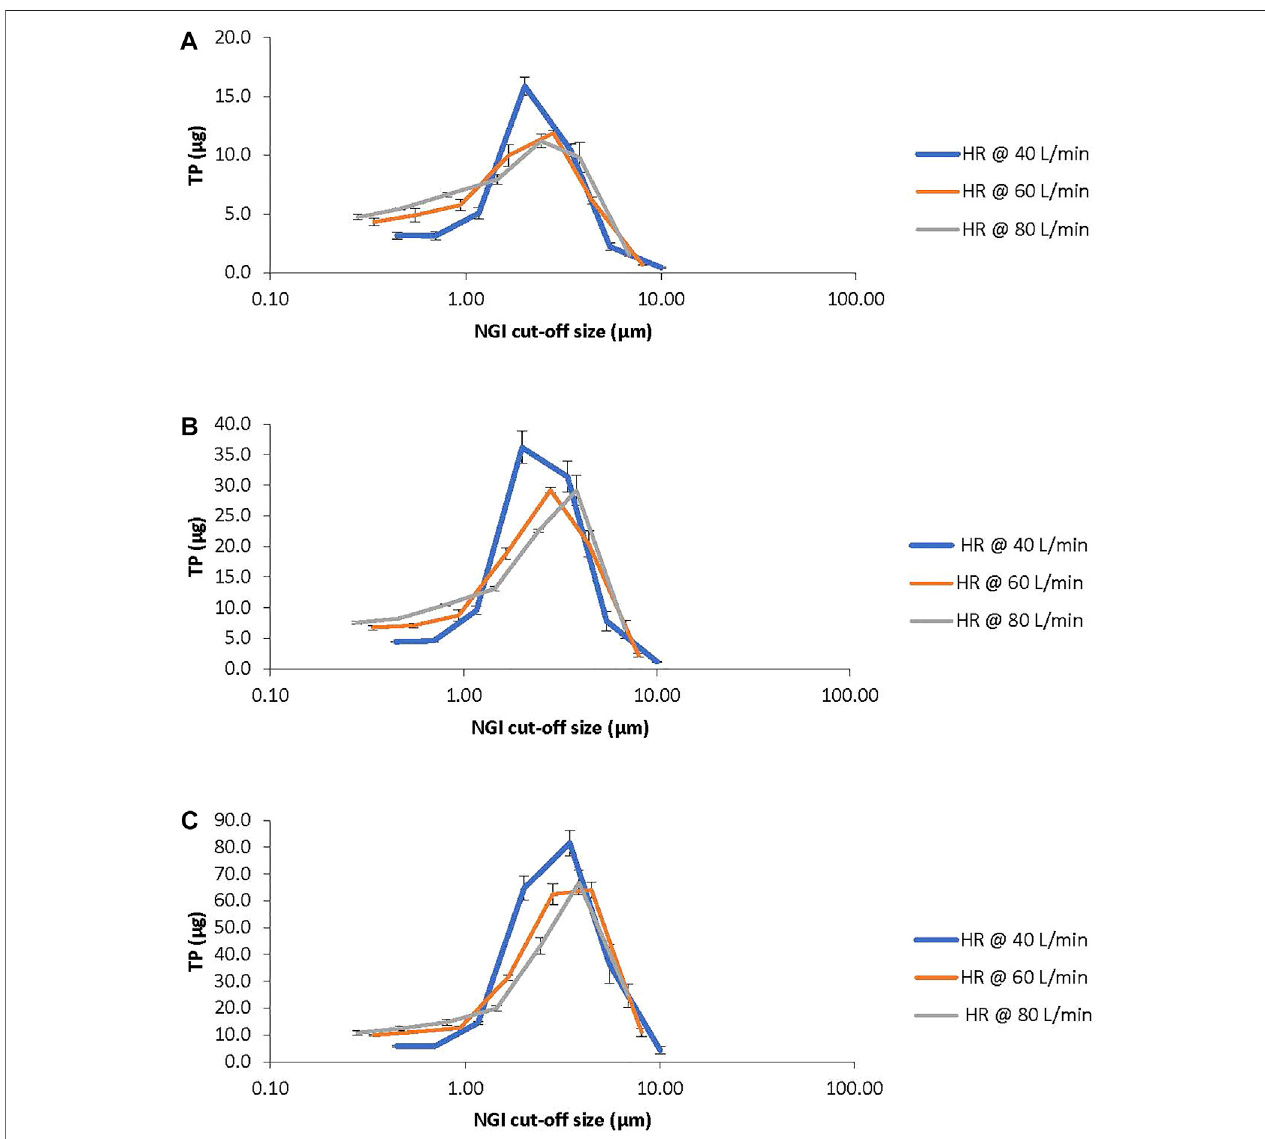
FIGURE4| TPAerosolDistributionPro fi lesfromtheNext GenerationImpactor(NGI). Thepro fi lesshowtherecoveryofTP(mean ±SD)from eachstageoftheNGI with respect to its stage cut-off diameter for high resistance (HR) device operated at 40 LPM (blue), 60 LPM (orange), and 80 LPM (gray). (A) : 8 mg TPIP capsules. (B) : 16 mg TPIP capsules. (C) : 32 mg TPIP capsules.